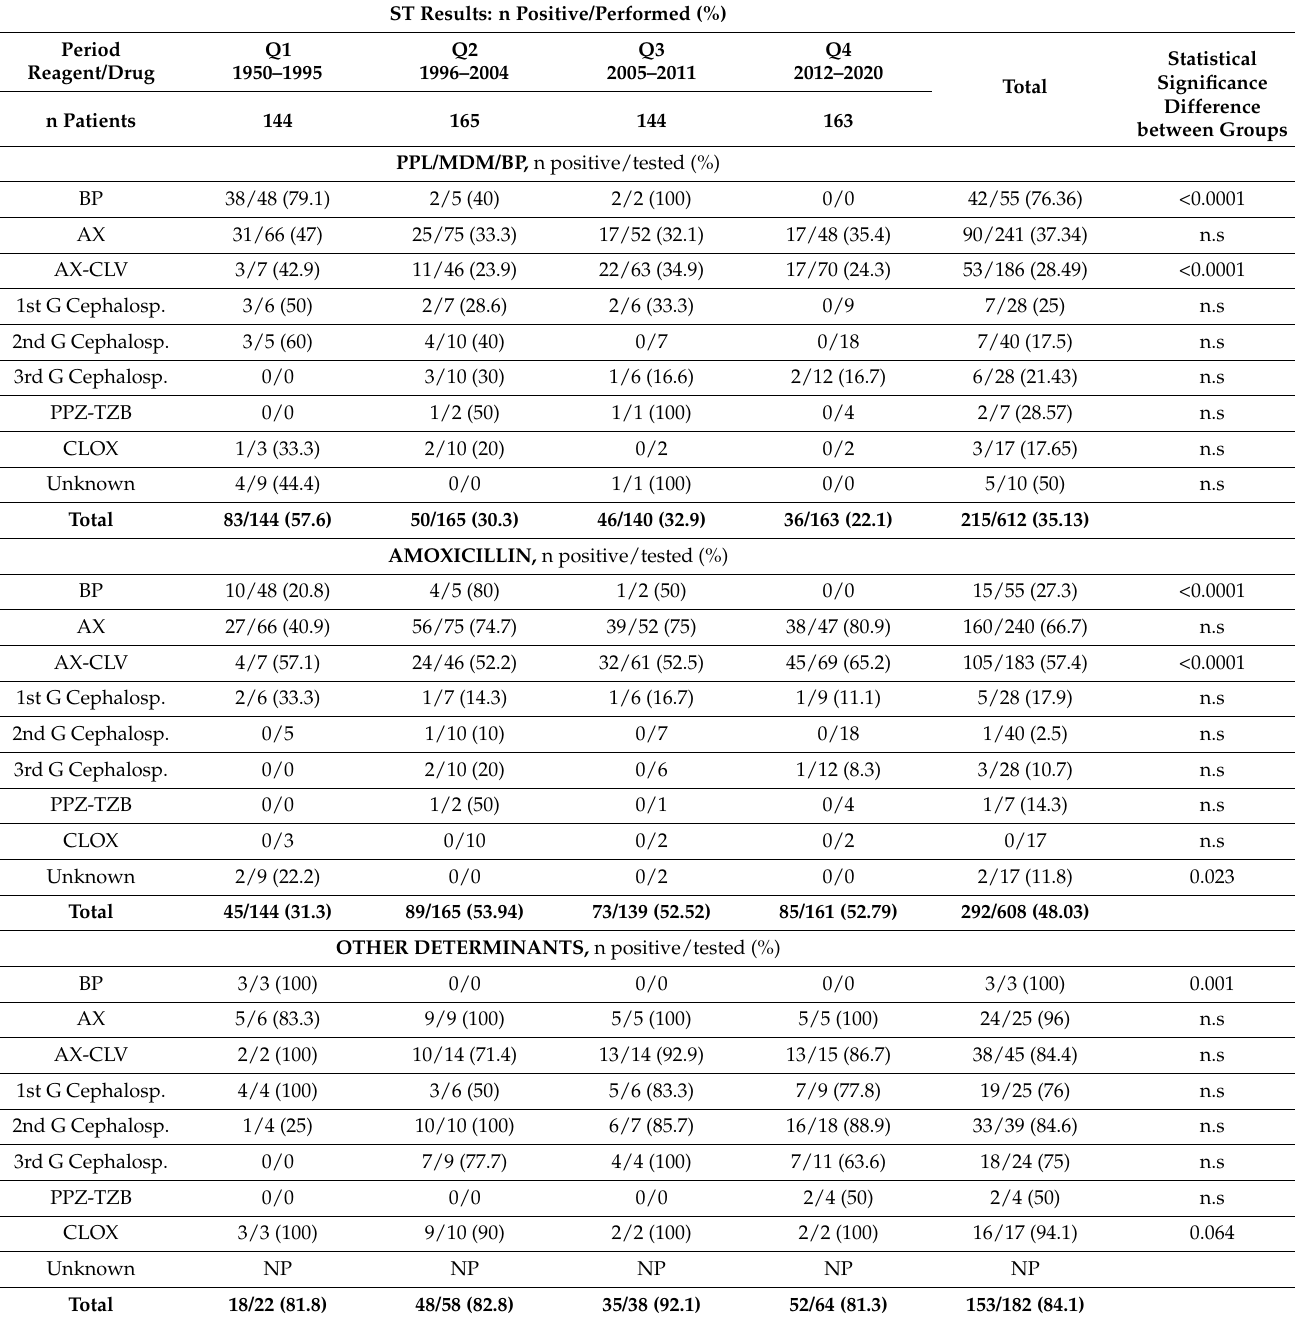
Table 2. Positive skin test results with the different